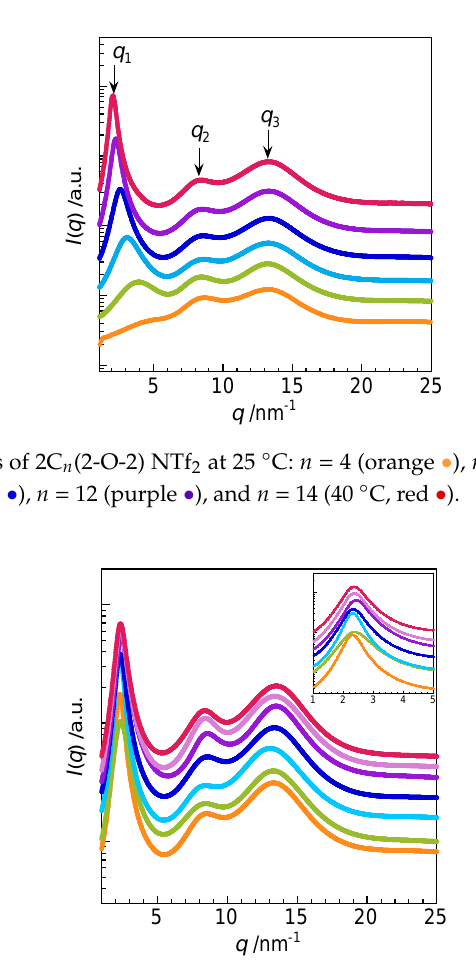
Figure 3. WAXS profiles of 2C n (2-O-2) NTf 2 at 25 °C: n = 4 (orange ● ), n = 6 (yellow green ● ), n = 8 (sky blue ● ), n = 10 (blue ● ), n = 12 (purple ● ), and n = 14 (40 °C, red ● ).